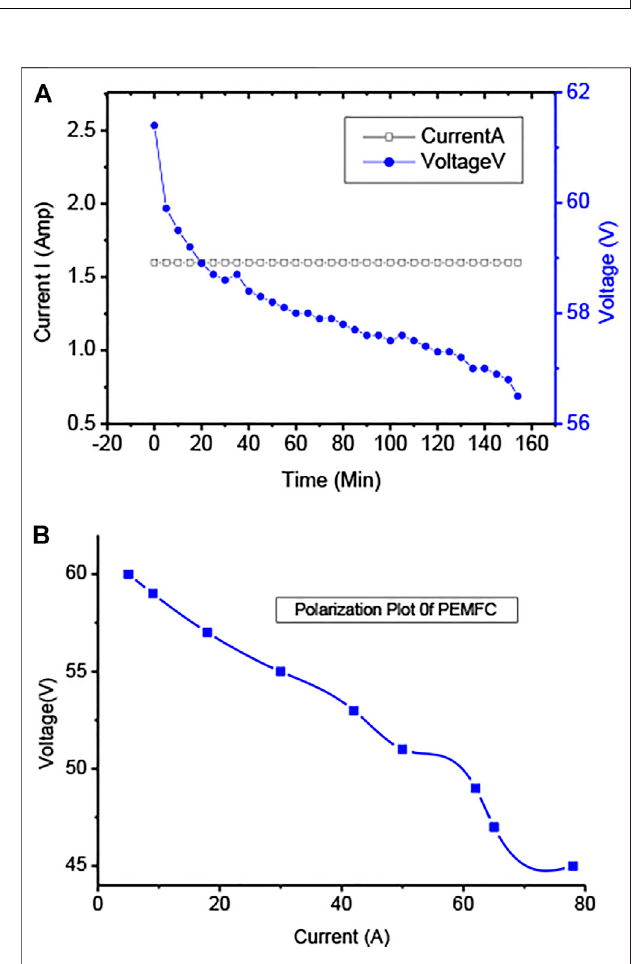
FIGURE 7 | (A) Polarization (IV vs. time) curve of hydrogen discharge of MH tanks at 40 ° C and (B) polarization plot at the loaded period of